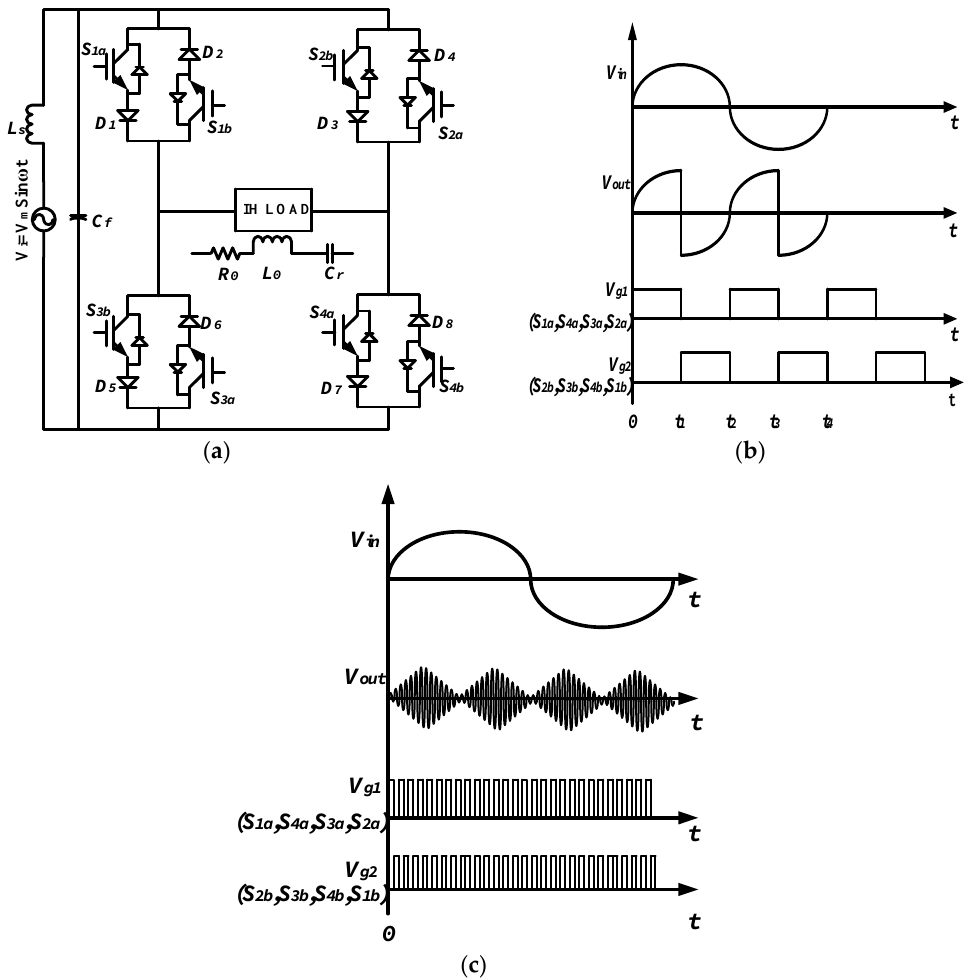
Figure 4. Power circuit of SPMC and its output voltage waveform ( a ) SPMC as a resonant converter for (IH) application; ( b ) Output voltage waveform of SPMC as frequency changer operation (at 100 Hz output) and ( c ) Output voltage waveform of SPMC as resonant converter (at HF output) using modified switching technique.